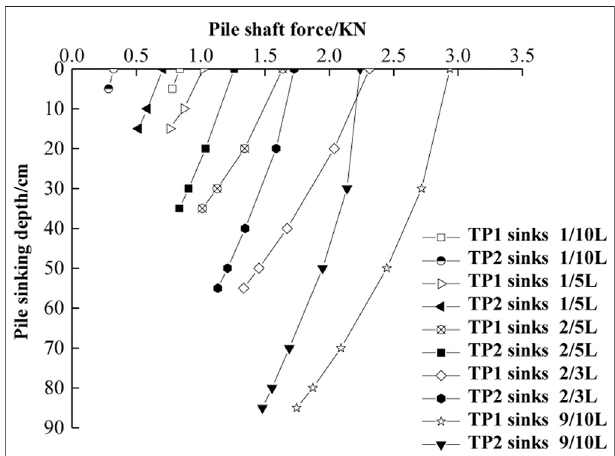
FIGURE 12 | Axial force distribution diagram of each test pile